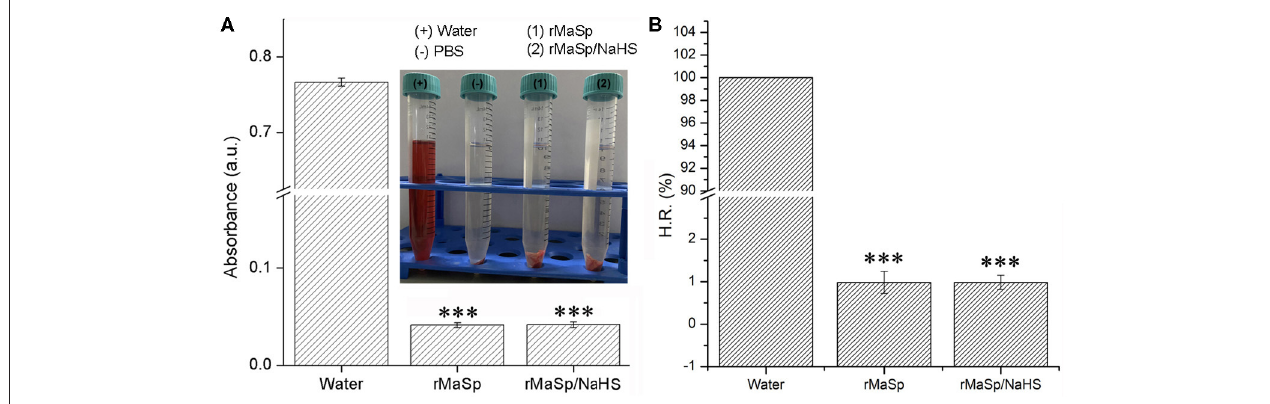
FIGURE 4 | Hemolysis assays of rMaSp membrane and rMaSp/NaHS membrane. (A) The absorbance of each group in hemolysis assays was tested by the use of an absorbance photometer and (B) the hemolysis rate of rMaSp membrane and rMaSp/NaHS membrane. *** p < 0.001 compared to control group, n = 6.